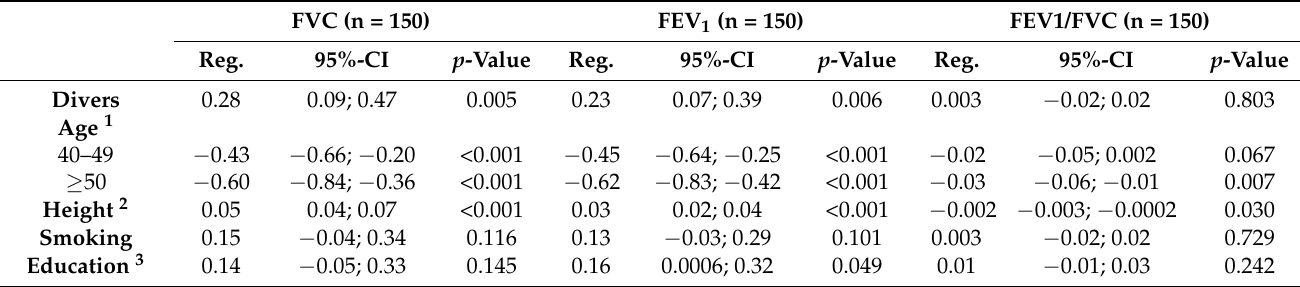
Table 3. Association of diving with lung function retrieved from multiple linear regressions.